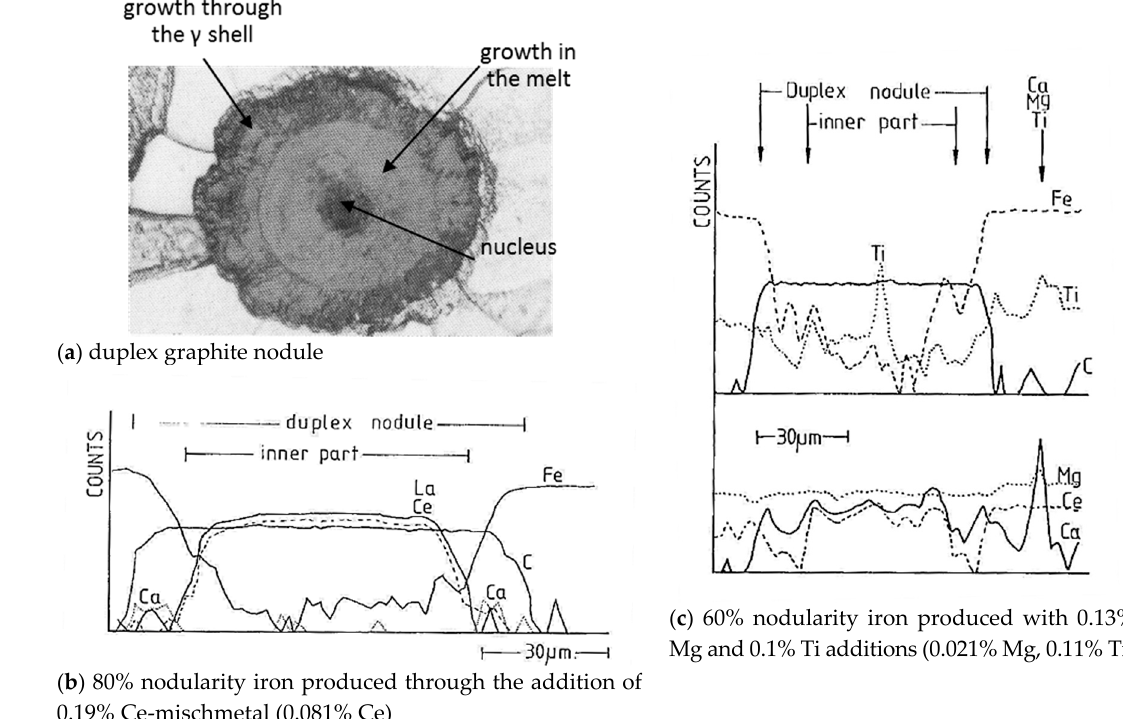
Figure 27. Secondary ion mass spectroscopy step-scans across duplex graphite nodules, reproduced from [110] with permission from Elsevier.